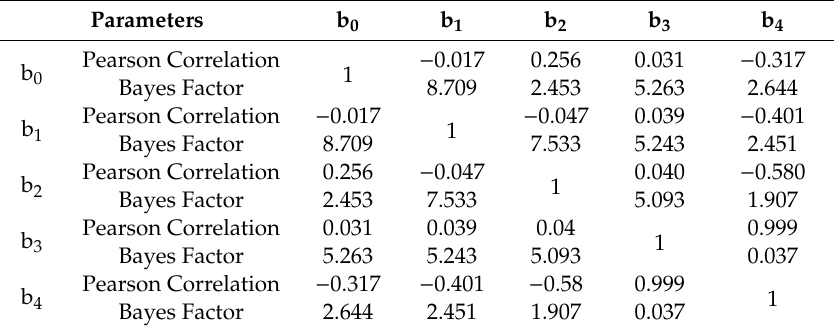
Table 3. Bayes factor inference on pairwise correlations among lactation curve